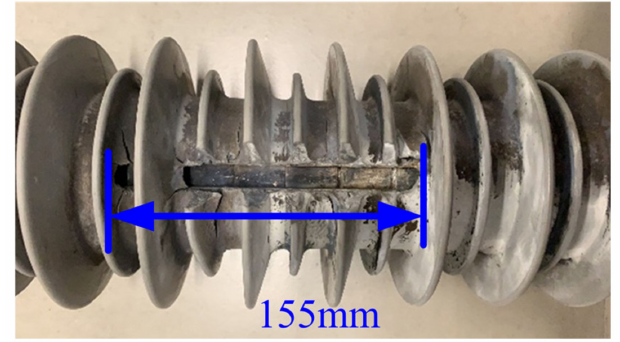
Figure 1. Exploded arrester.